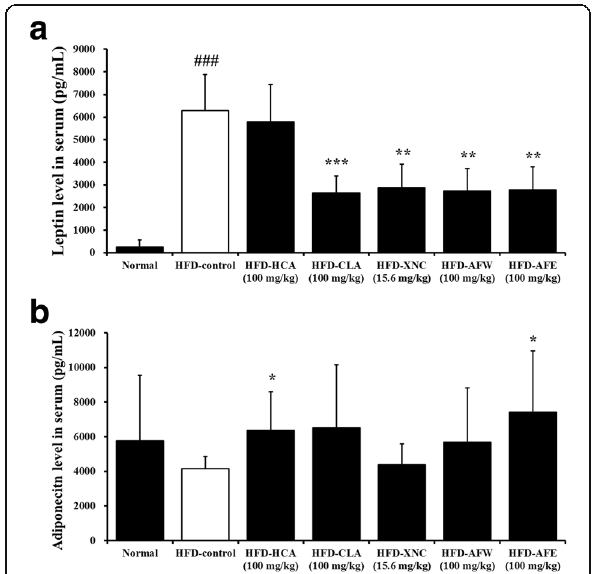
Fig. 4 Effect of 6-week treatment with Allium fistulosum aqueous extract (AFW) and A. fistulosum ethanolic extract (AFE) on serum adipocytokine and IGF-1 concentrations in high-fat diet (HFD)-in- duced obese mice, as assessed by enzyme-linked immunosorbent assay. Serum levels of ( a ) leptin, ( b ) adiponectin, and ( c ) IGF-1. Results are expressed as the mean ± standard error of the mean (SEM) ( n = 6). Normal, standard chow; HFD-control, HFD only; HFD- HCA, HFD plus 100 mg/kg Garcinia cambogia extract containing hydroxycitric acid; HFD-CLA, HFD plus 100 mg/kg conjugated linoleic acid; HFD-ORL, HFD plus 15.6 mg/kg Xenical (orlistat); HFD-AFW, HFD plus 100 mg/kg AFW; HFD-AFE, HFD plus 100 mg/kg AFE. ### p < 0.001 compared with the normal control group; * p < 0.05, ** p < 0.01, *** p < 0.001 compared with the HFD-control